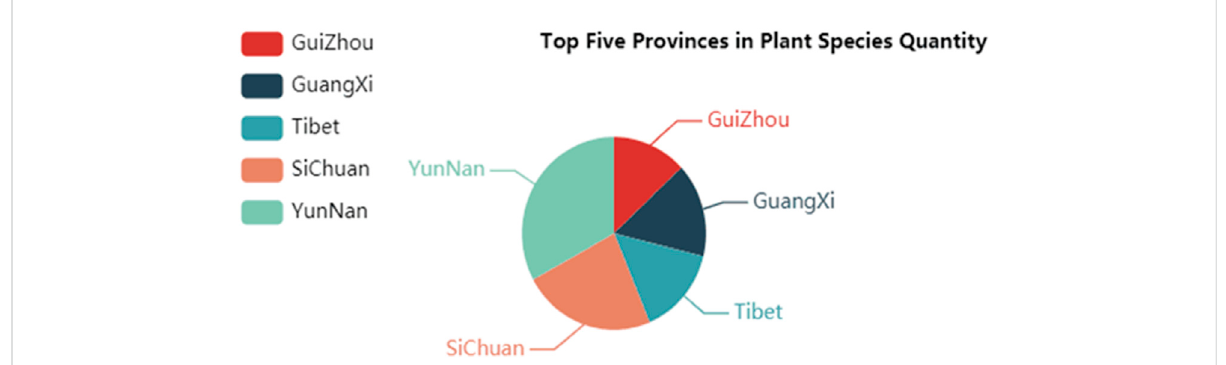
FIGURE 6 The top fi ve provincial administrative regions regarding the number of plant species in China. Different provincial administrative regions correspond to different colours, and the fan size represents the scale of plant